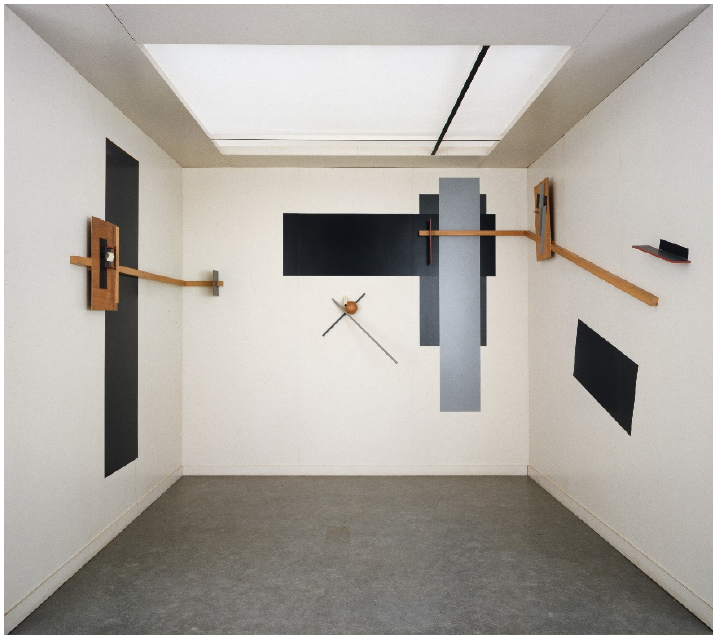
Figure 5. El Lissitzky, Prounenraum, 1923, reconstruction Van Abbemuseum, 1971. Van Abbemuseum. Photo: Peter Cox.